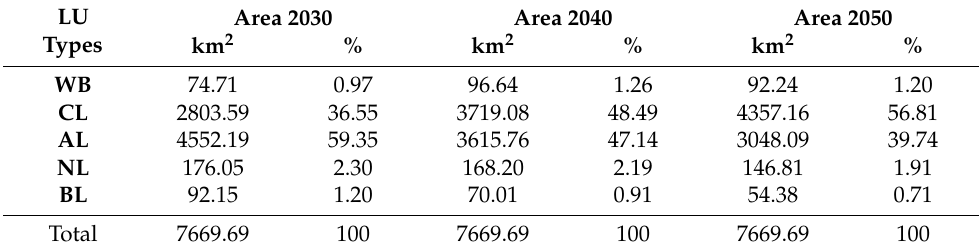
Figure 12. Spatial distribution of FLUCC of 2030, 2040, and 2050. ( a ) FLUCC 2030, ( b ) FLUCC 2040, and ( c ) FLUCC 2050. Table 9. Statistic of FLUCC simulation under different scenarios 2030, 2040, and